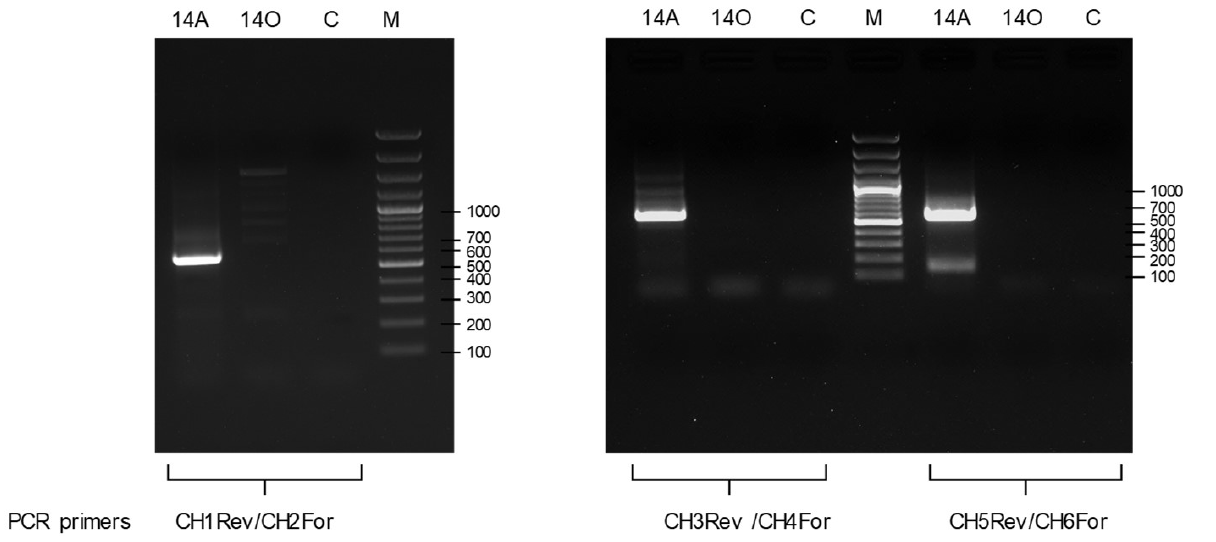
Figure 2. Amplification assays using RNA preparations from CtaHVd-LR1-positive (isolate 14A in 2018) and -negative (14O) samples and primer pairs CH1Rev/CH2For ( left ). CH3Rev/CH4F ( middle ) or CH5Rev/CH6F ( right ); C, negative control in which ddH 2 O instead of cDNA was added to the amplification mix; M, molecular marker is a 100 bp DNA ladder.